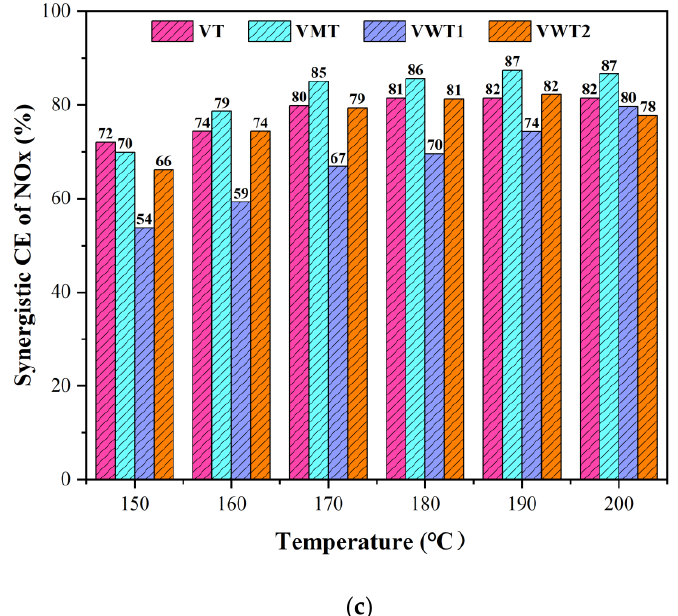
Figure 1. ( a ) The CE of o-DCE of four catalysts at 6000 h −1 , with an initial concentration of 100 ppm; ( b ) the synergistic CE of o-DCB of four catalysts with the introduction of 350 ppm NO and 350 ppm NH 3 ; ( c ) the synergistic CE of NO.